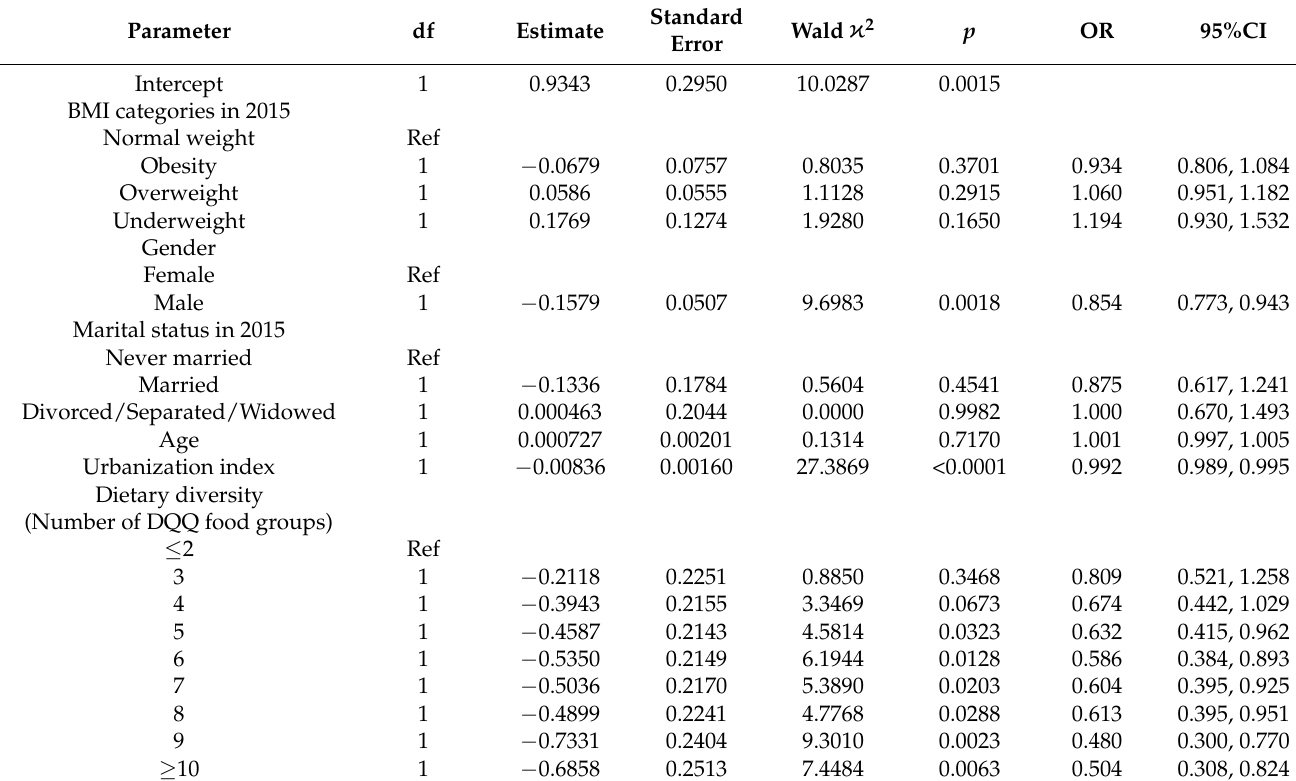
Table 1. Descriptive statistics of Table 3. Associations of dietary diversity with psychological stress.